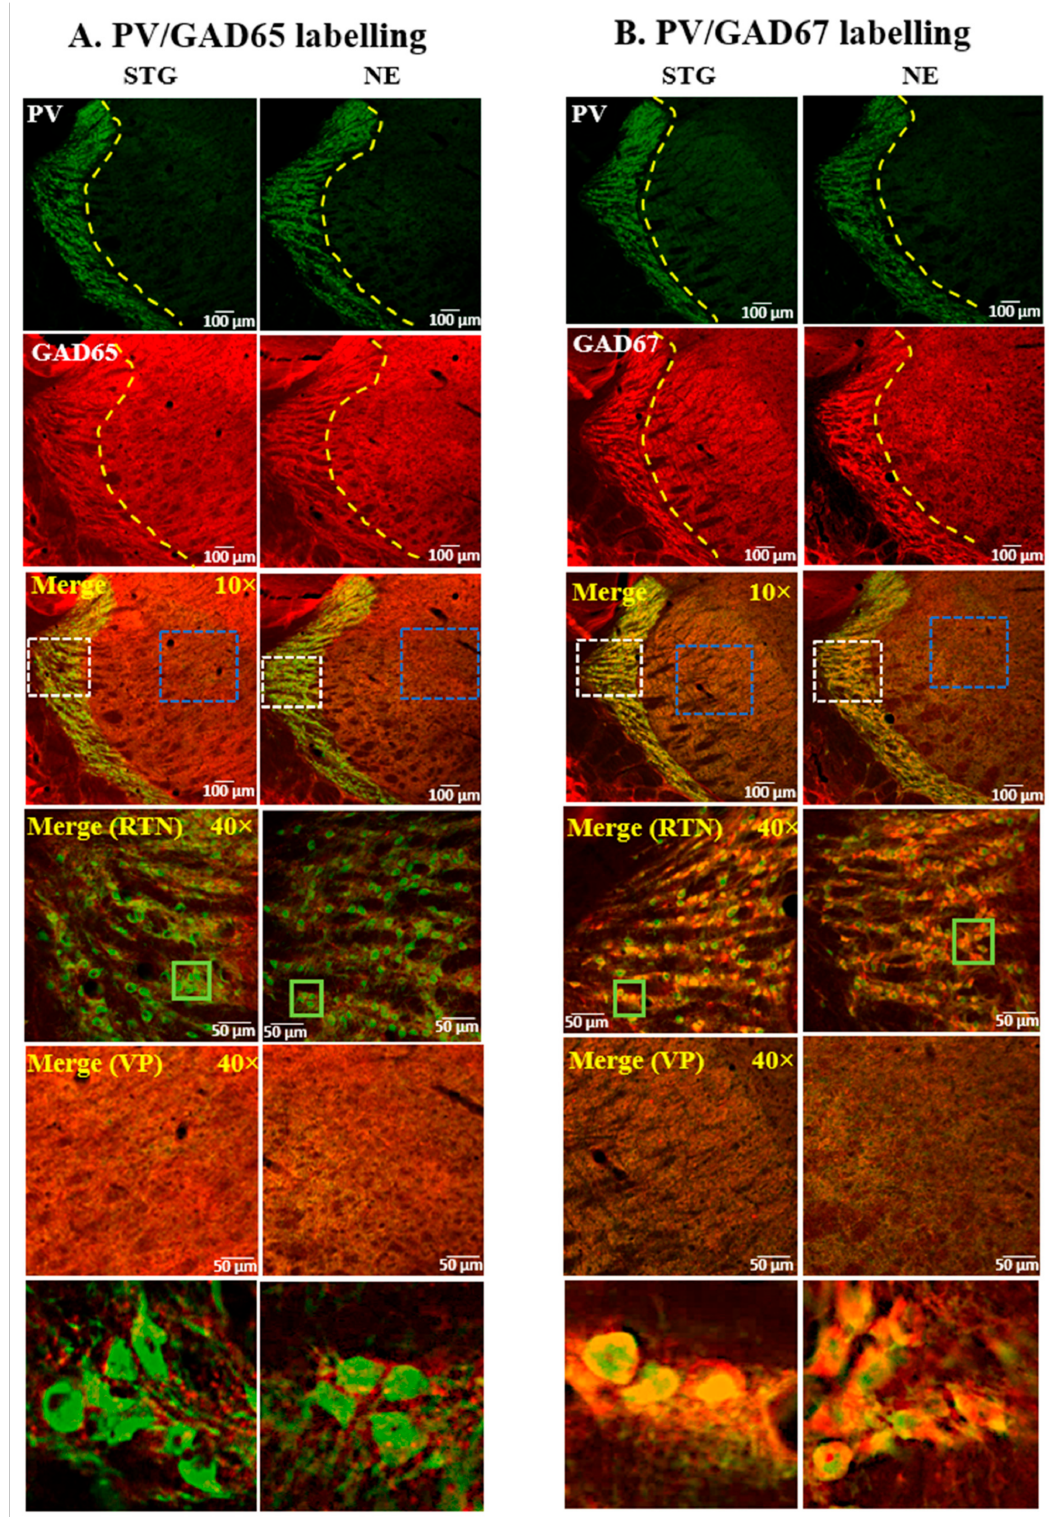
Figure 3. Representative confocal images showing the expression of ( A ) GAD65 or ( B ) GAD67 and PV in the thalamus of epileptic stargazers (STG) and non-epileptic littermates (NE). Merged images at low magnification (10 × ) and medium magnification (40 × ) are shown. White and blue dotted boxes in the merged images were magnified in the fourth and fifth panel, respectively. Green boxes in the fourth panel were magnified in the bottom panels of figures ( A , B ) to show punctate structures and colocalisation,